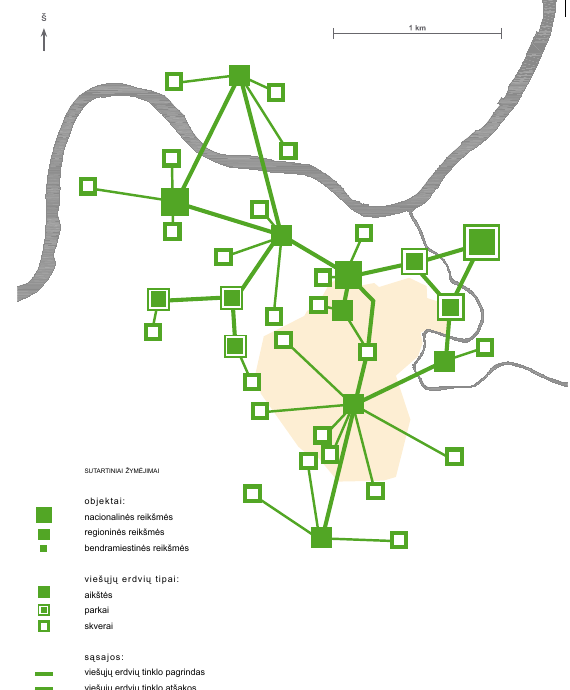
ma (objektų lygmuo) Fig. 4. Public space system of Vilnius central district (object